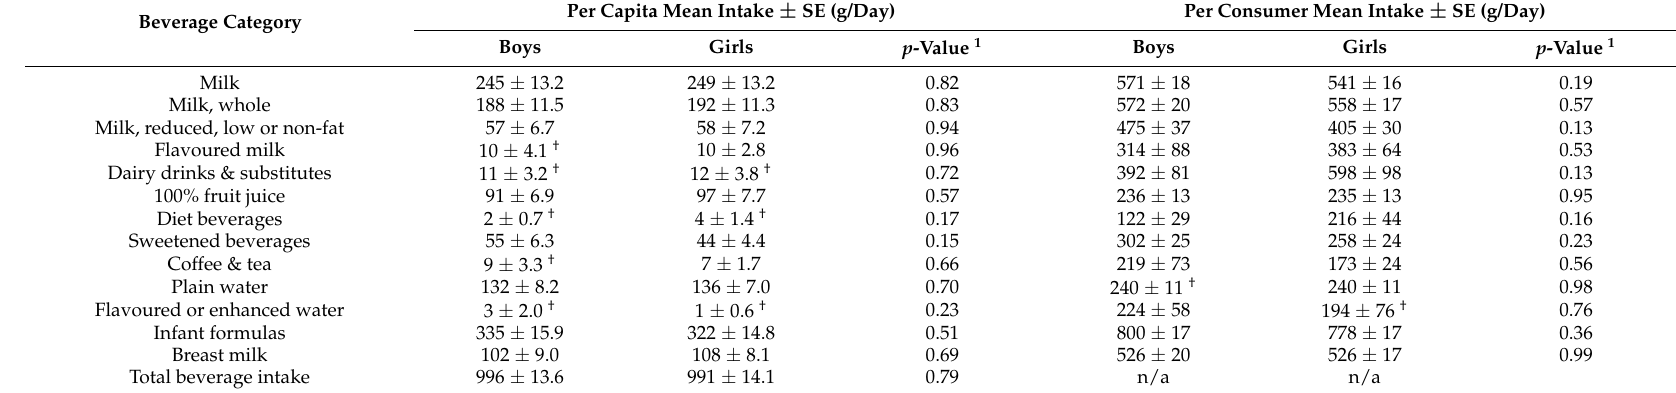
Table 2. Beverage consumption by sex ( n = 2740).